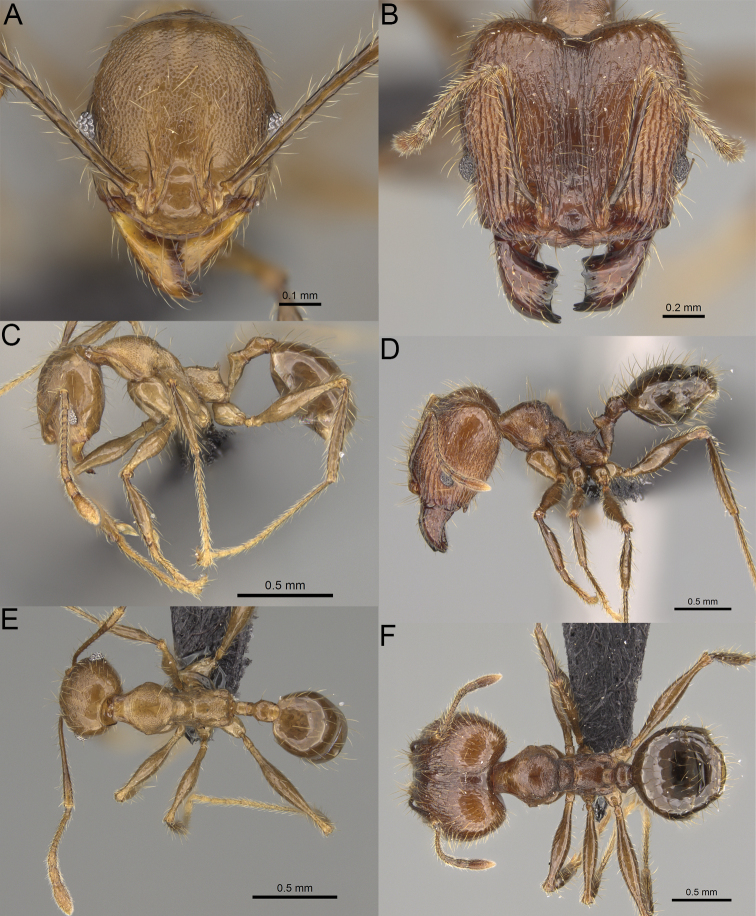
Pheidole
tampony sp. nov., full-face view (A), profile (C), and dorsal view (E) of paratype minor worker (CASENT0923285) and full-face view (B), profile (D), and dorsal view (F) of holotype major worker (CASENT0809550).